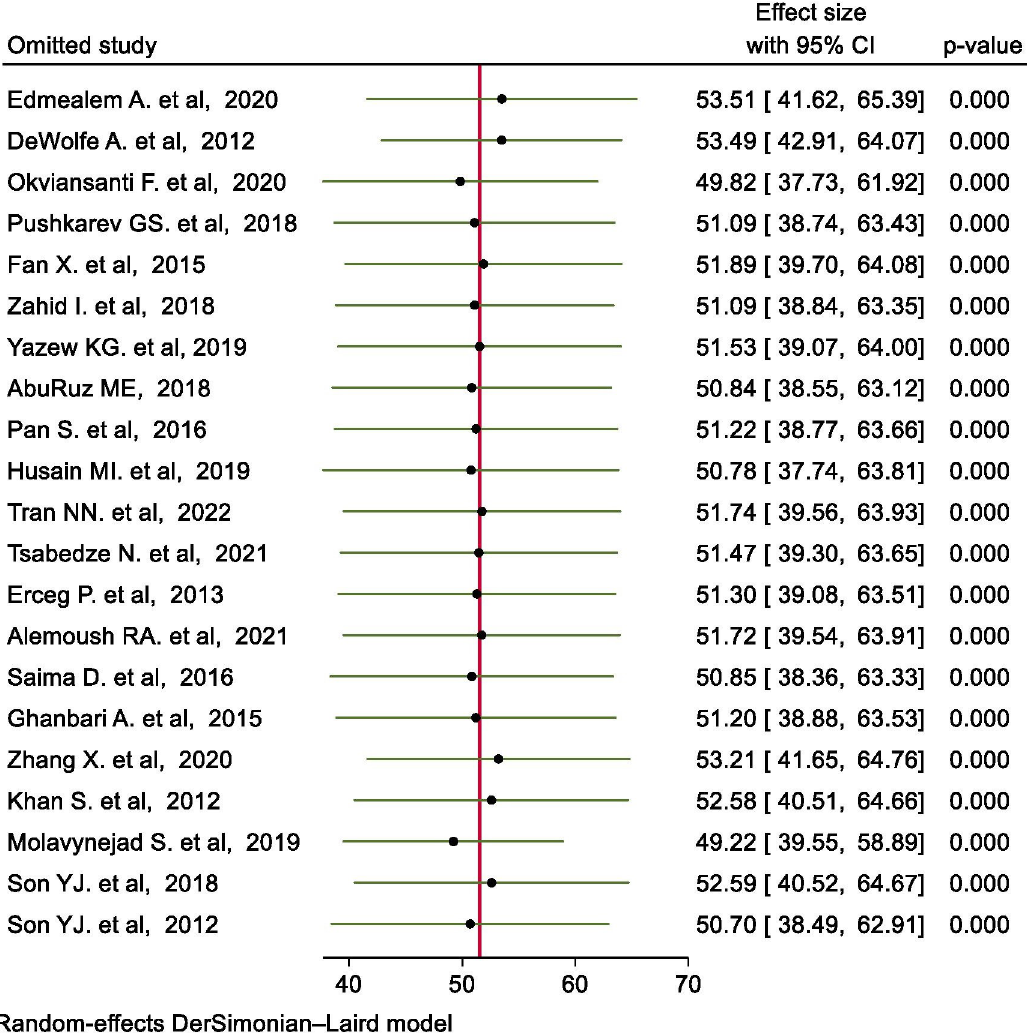
Fig 4. Result of sensitivity analysis of the 21